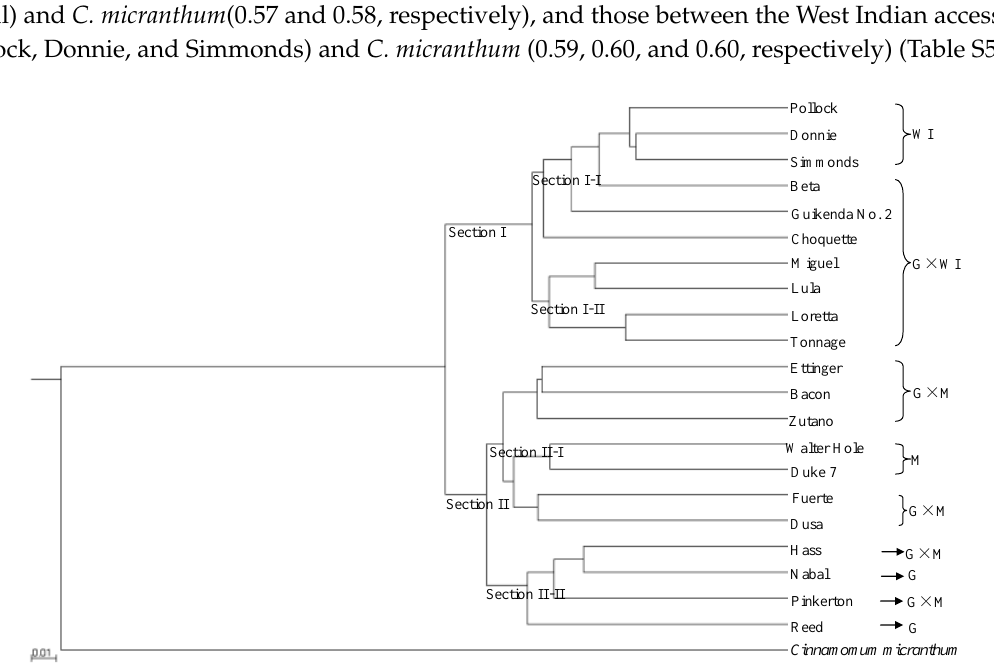
accessions joined into a single cluster, and one Guatemalan accession and one Guatemalan × West Indian hybrid accession clustered